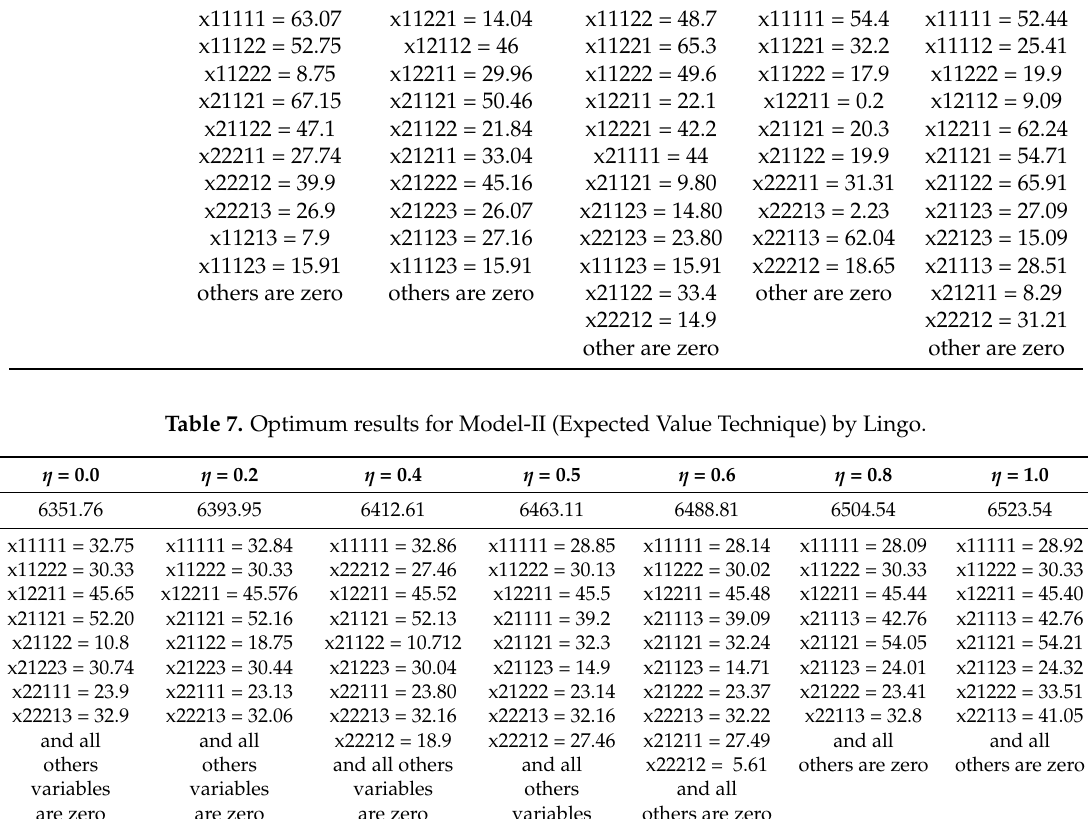
Table 6. Optimum results for Model-I and Model-II (Hamzehee Method) by Lingo.